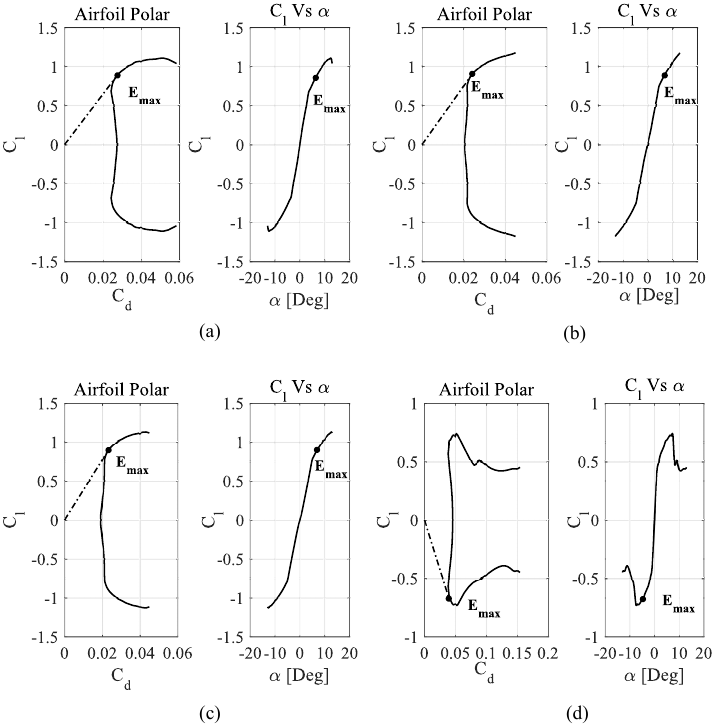
Figure 5. Airfoil polars at azimuthal positions: ( a ) first azimuthal position; ( b ) second azimuthal position; ( c ) third azimuthal position; ( d ) fourth azimuthal